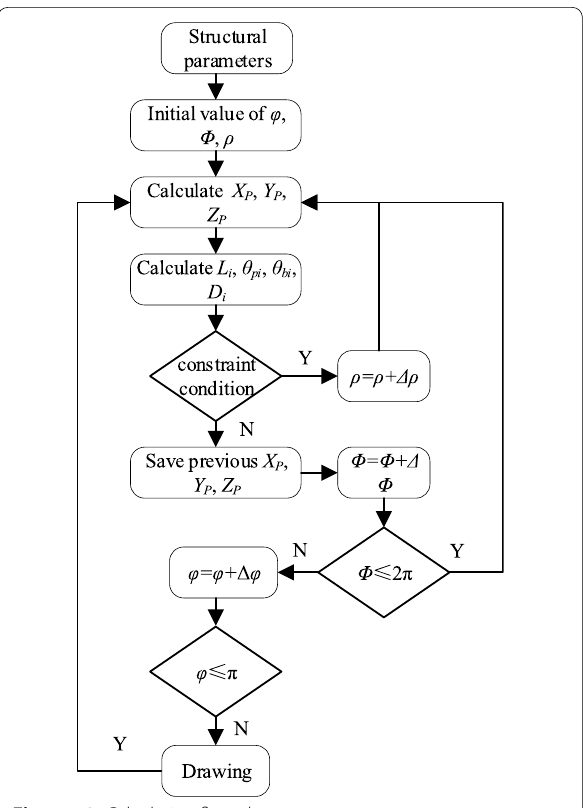
Figure 13 Calculation flow